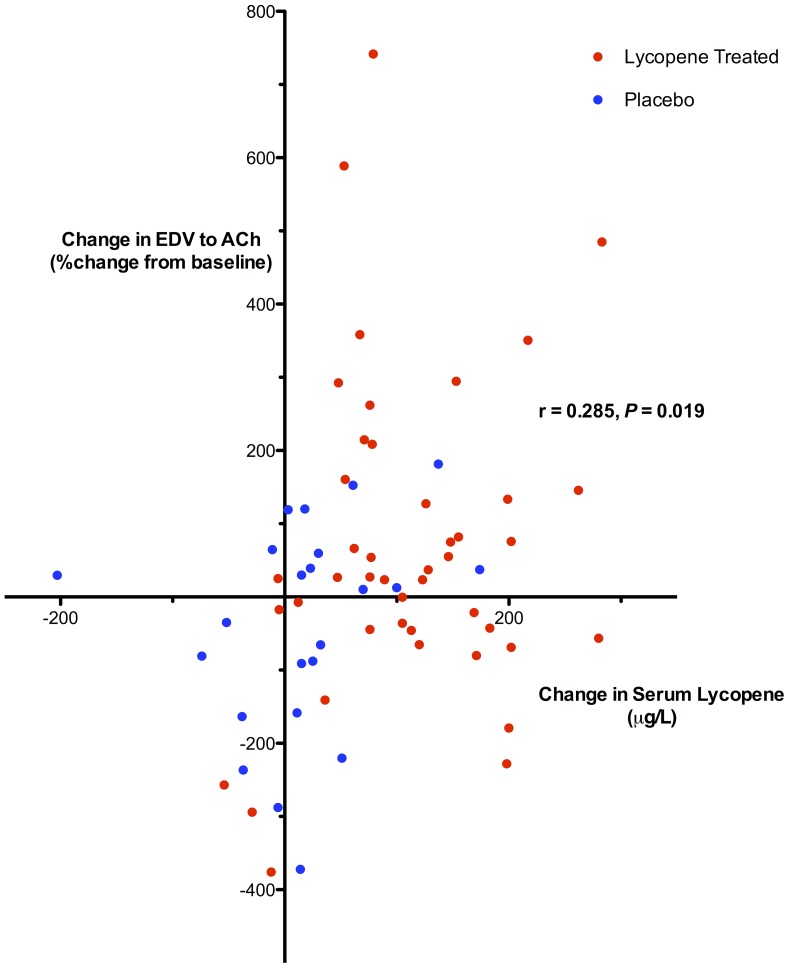
Post-hoc correlation between serum lycopene concentrations and EDV.Relationship between absolute change in serum lycopene concentrations and absolute change in endothelial dependent vasodilatation (EDV; forearm blood flow response to 15 µg/min acetylcholine measured as %change from preceding saline baseline) for all trial subjects. Absolute change in serum lycopene calculated as final visit serum lycopene minus baseline serum lycopene. Absolute change in EDV calculated as final visit EDV minus baseline EDV. r: correlation coefficient calculated using Pearson correlation analysis.